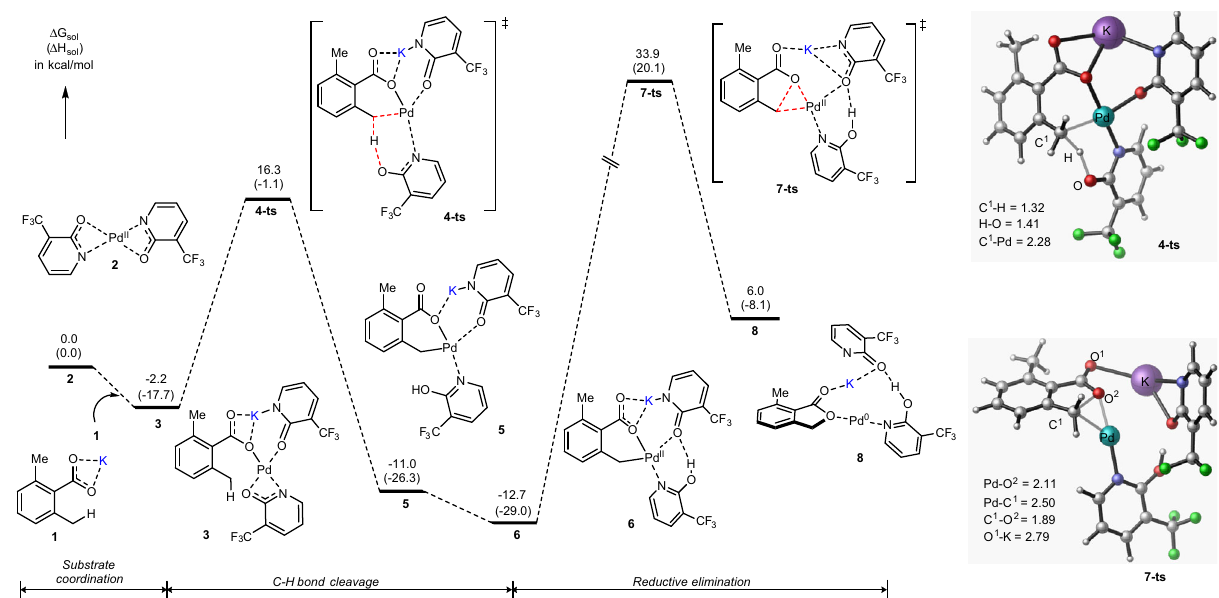
Fig. 2 The calculated free energy surface. Energy pro fi le for the substrate coordination, C – H bond activation, and direct C – O reductive elimination steps for the benzolactonization reaction, and geometries of the key transition states (bond distances are given in Å).